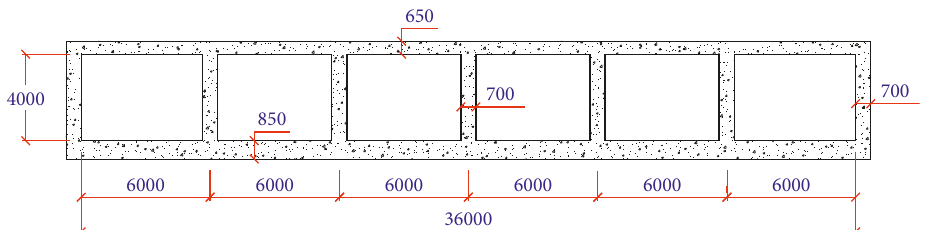
Figure 3: Cross section of the selected large-space underground structure.